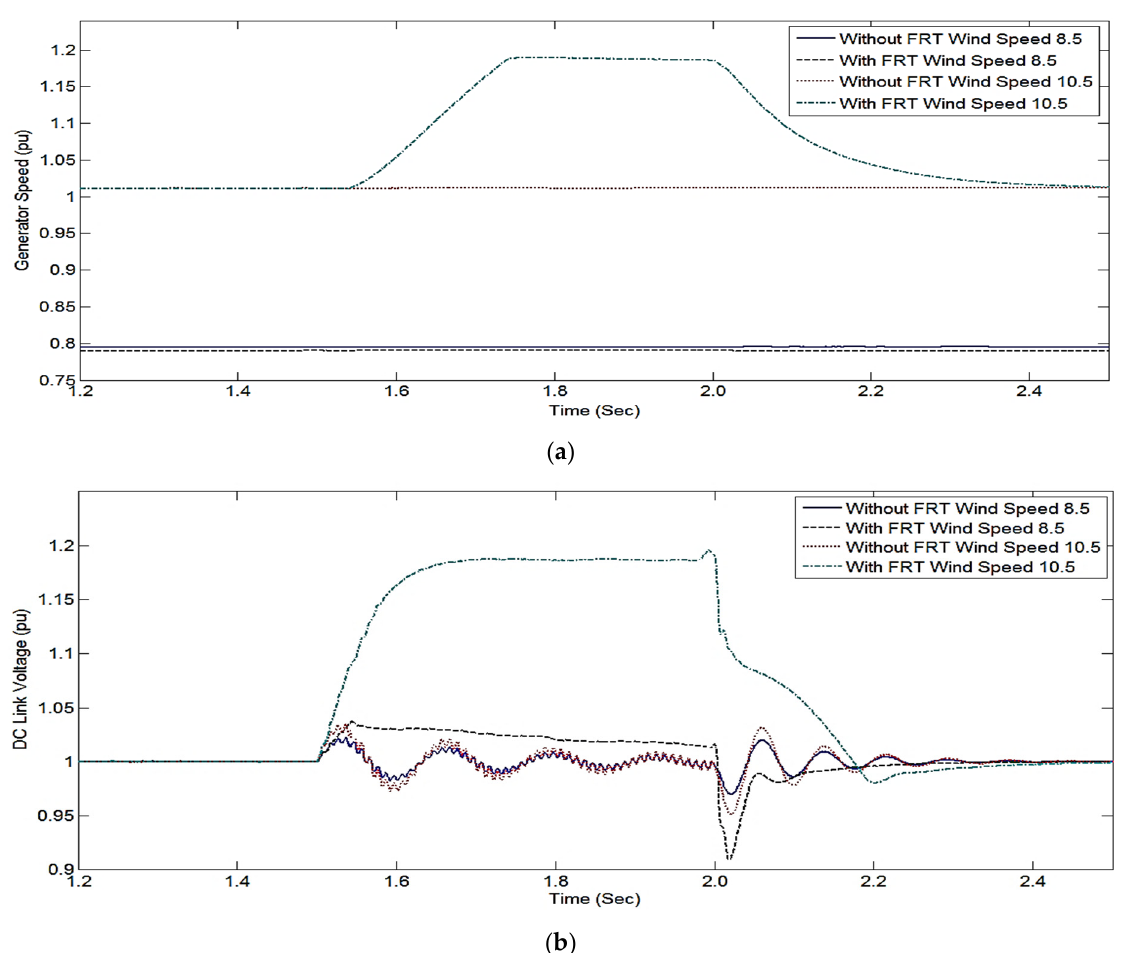
Figure 8. Behavior of WECS during unsymmetrical fault, with and without FRT control for 8.5 m/s and 10.5 m/s wind speeds: ( a ) Generator Speed ( b ) dc-link Voltage.